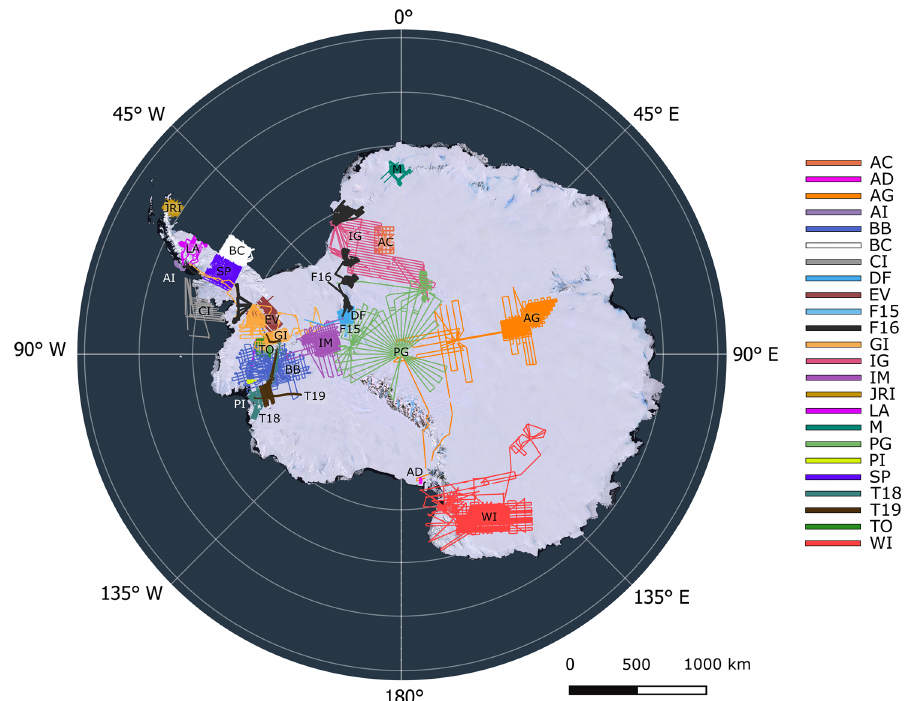
Figure 1. Map showing all the published datasets included in this data release. The colours are the same as those used on the data portal interface. Abbreviations are as follows: AC: AFI Coats Land (2001–2002); AD: Andrill HRAM (2008–2009); AG: AGAP (2007–2009);